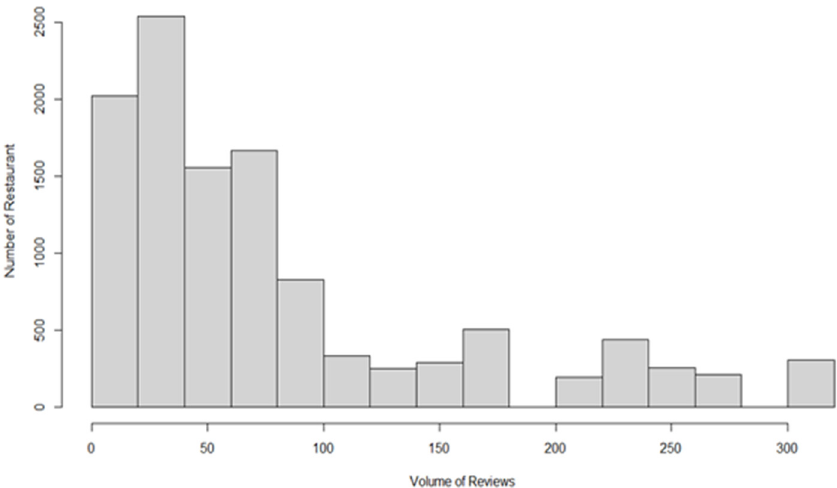
Figure 3. Distribution of volume of